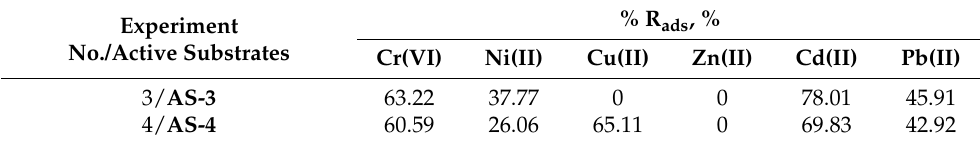
Table 2. Comparison of the results of %R ads obtained in Experiments 3 and 4.